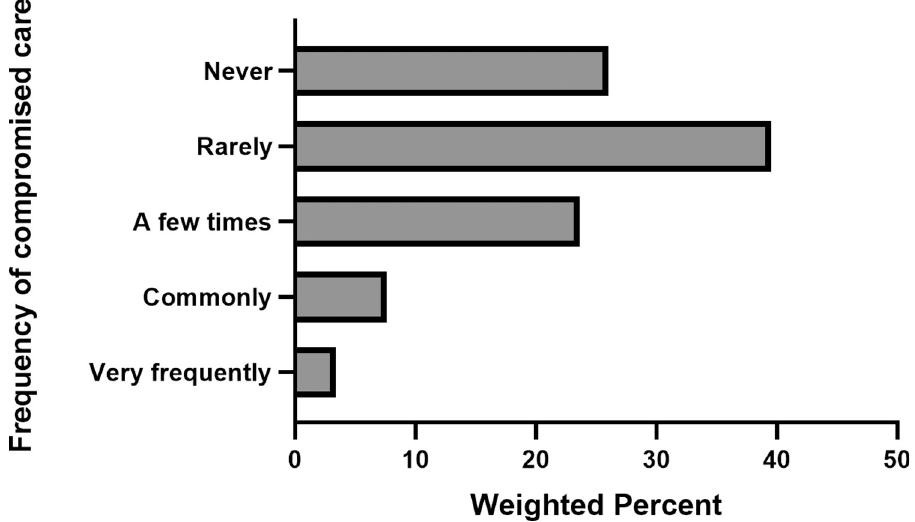
Fig 2. Frequency of compromised patient care due to resource limitations during the worst two weeks of the COVID-19 pandemic.